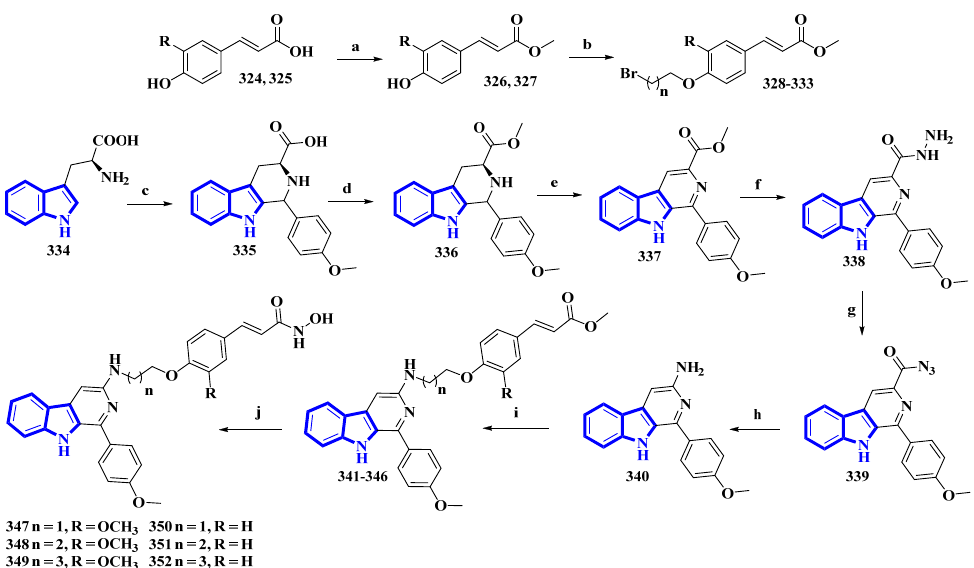
Figure 21. Synthesis of hydroxamic derivatives 347–352 . (a) SOCl 2 , CH 3 OH, 0 °C, 1 h, and then 65 °C, 4 h; (b) ω -Dibromoalkane, K 2 CO 3 , CH 3 CN, reflux, 4 h, 66–75%; (c) 4-methoxybenzaldehyde, AcOH, reflux, 4 h; (d) Thionyl chloride, CH 3 OH, 0 °C, 1 h, and then 65 °C, 6 h; (e) KMnO 4 , DMF, rt, 5 h; (f) Hydrazine monohydrate, CH 3 OH, 50 °C, 6 h; (g) NaNO 2 , HCl; (h) AcOH, H 2 O, 50 °C, 6 h; (i) 328–333 , K 2 CO 3 , CH 3 CN, reflux, 12 h; (j) NH 2 OK, CH 3 OH, rt, 8–12 h, 46–56%.